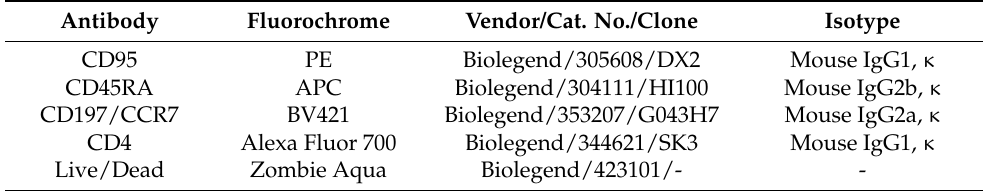
Table 2. Antibodies used for flow cytometry to phenotype T cell subsets. PE: Phycoerythrin, APC: Allophycocyanin, BV: Brilliant